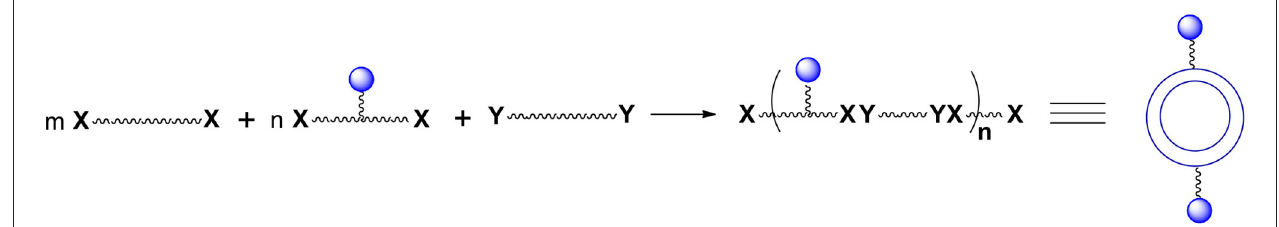
FIGURE 2 | The number of “handles” (and therefore final surface moieties) on the capsules’ surface can be controlled. To this end one must react bifunctional compound comprising Ys with a mixture of bifunctional compounds comprising Xs. This mixture contains compounds equipped and non-equipped with future handles (blue